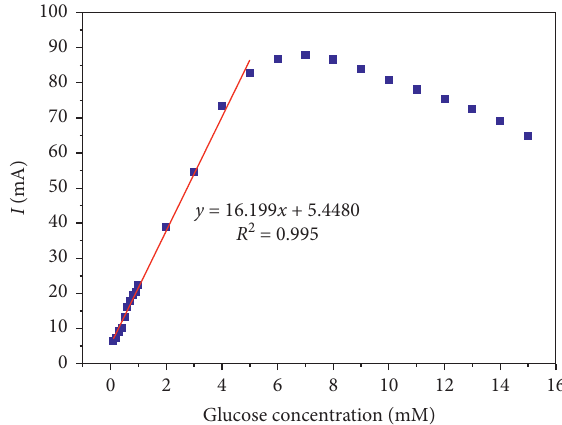
Figure 8: Calibration curve of the glucose concentration versus current for the Cu-CuO/PANI/316L nonenzymatic glucose sensor at an applied potential of 0.63 V in 0.1M